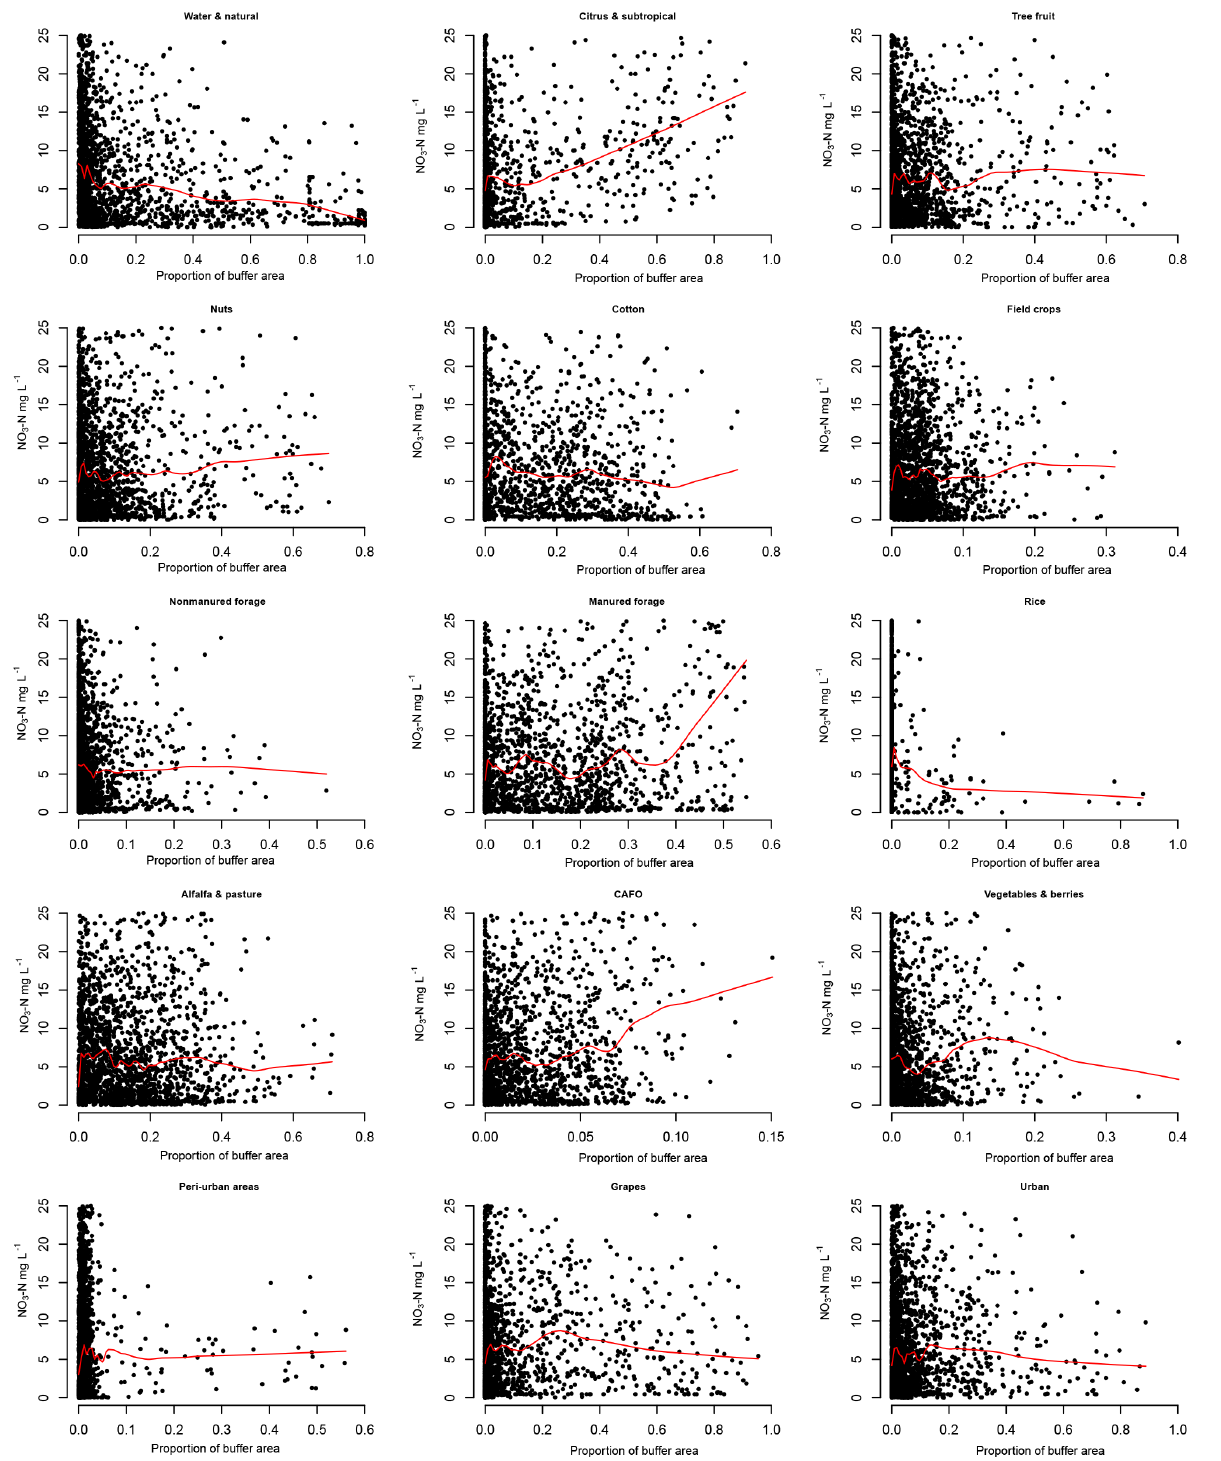
Figure 4. Scatterplot of proportion of land use within each well buffer versus well nitrate concentration for each of the 15 land use or crop groups in scenario 1. The red line is a locally weighted scatterplot smoothing line (Cleveland, 1979). Note that each plot shows nitrate concentrations between 0 and 25mgL − 1 NO 3 -N (approximately 5 times the median value); however, all data were used to calculate the plotted smoothing lines. The x axis is scaled differently among subplots for better